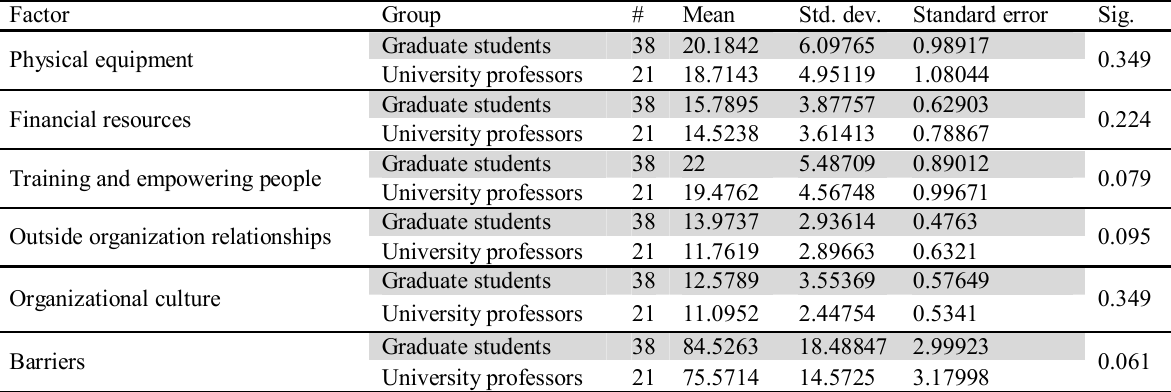
The summary of t-student